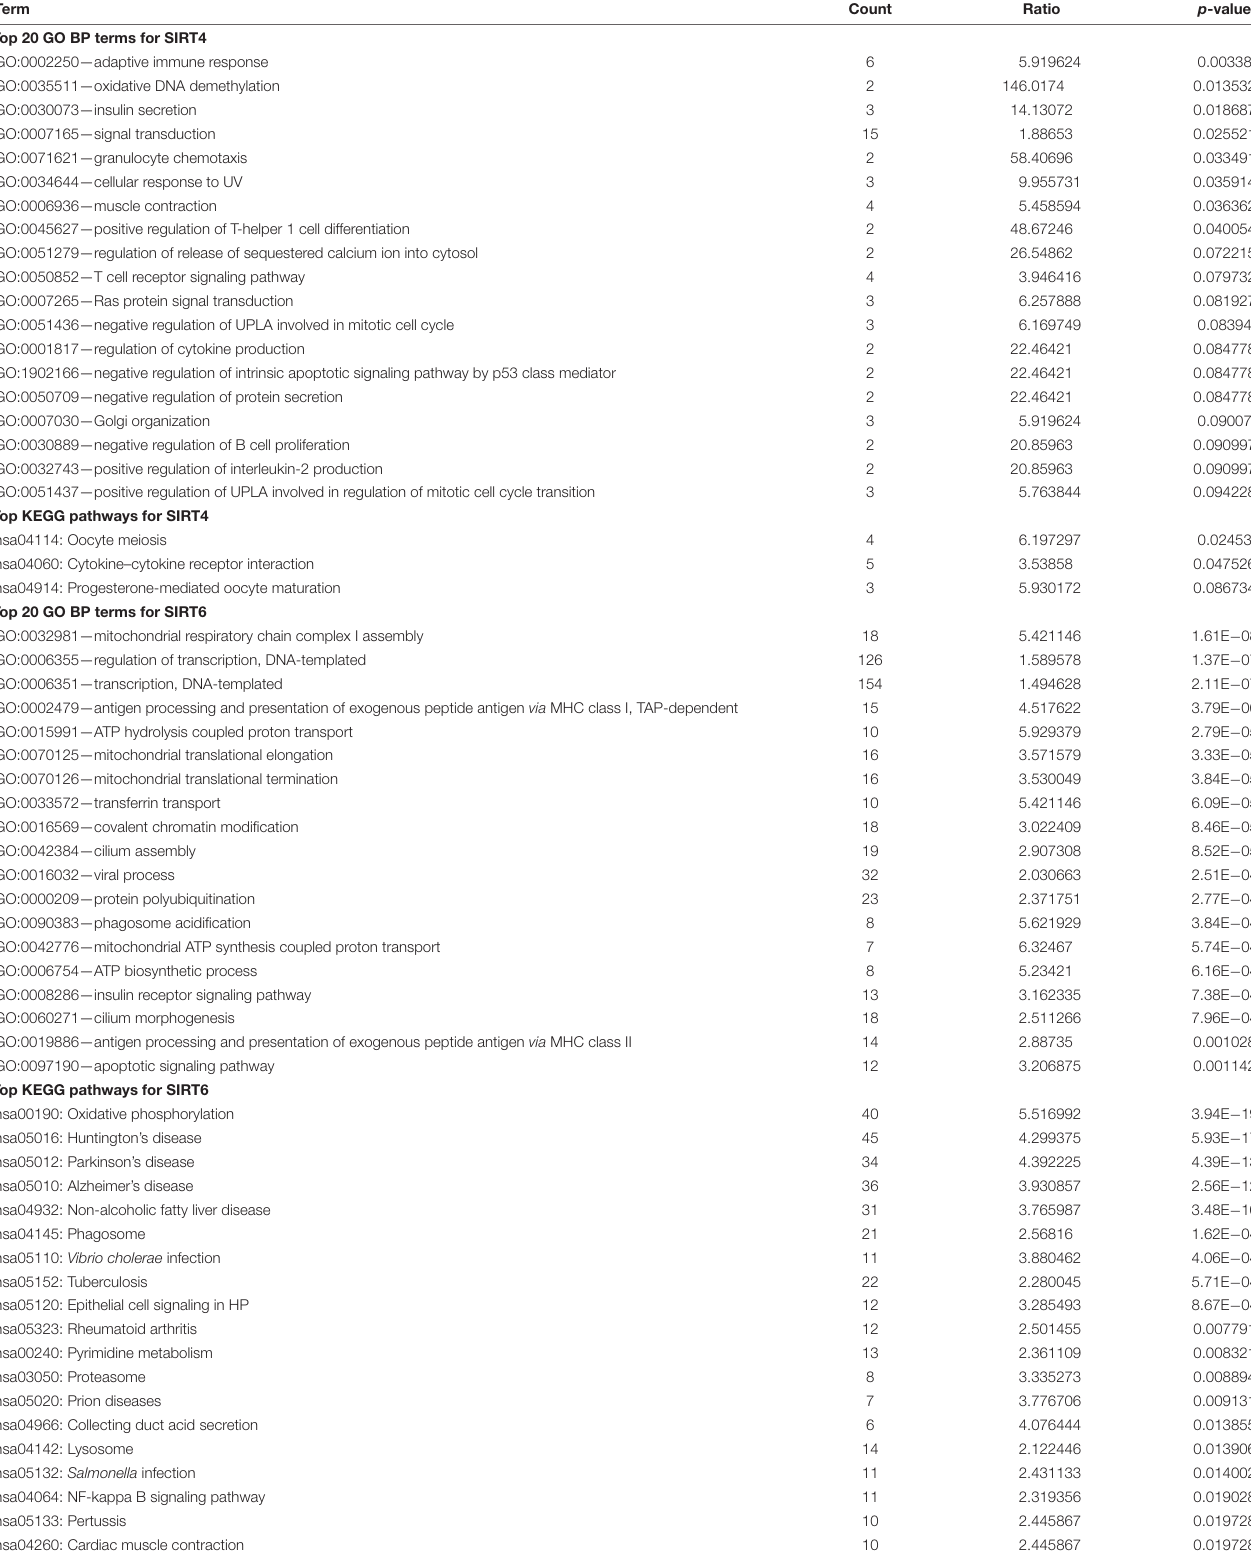
TABLE 2 | Top Gene Ontology (GO) terms and Kyoto Encyclopedia of Genes and Genomes (KEGG) pathways for SIRT4 and SIRT6. Term Count Ratio p